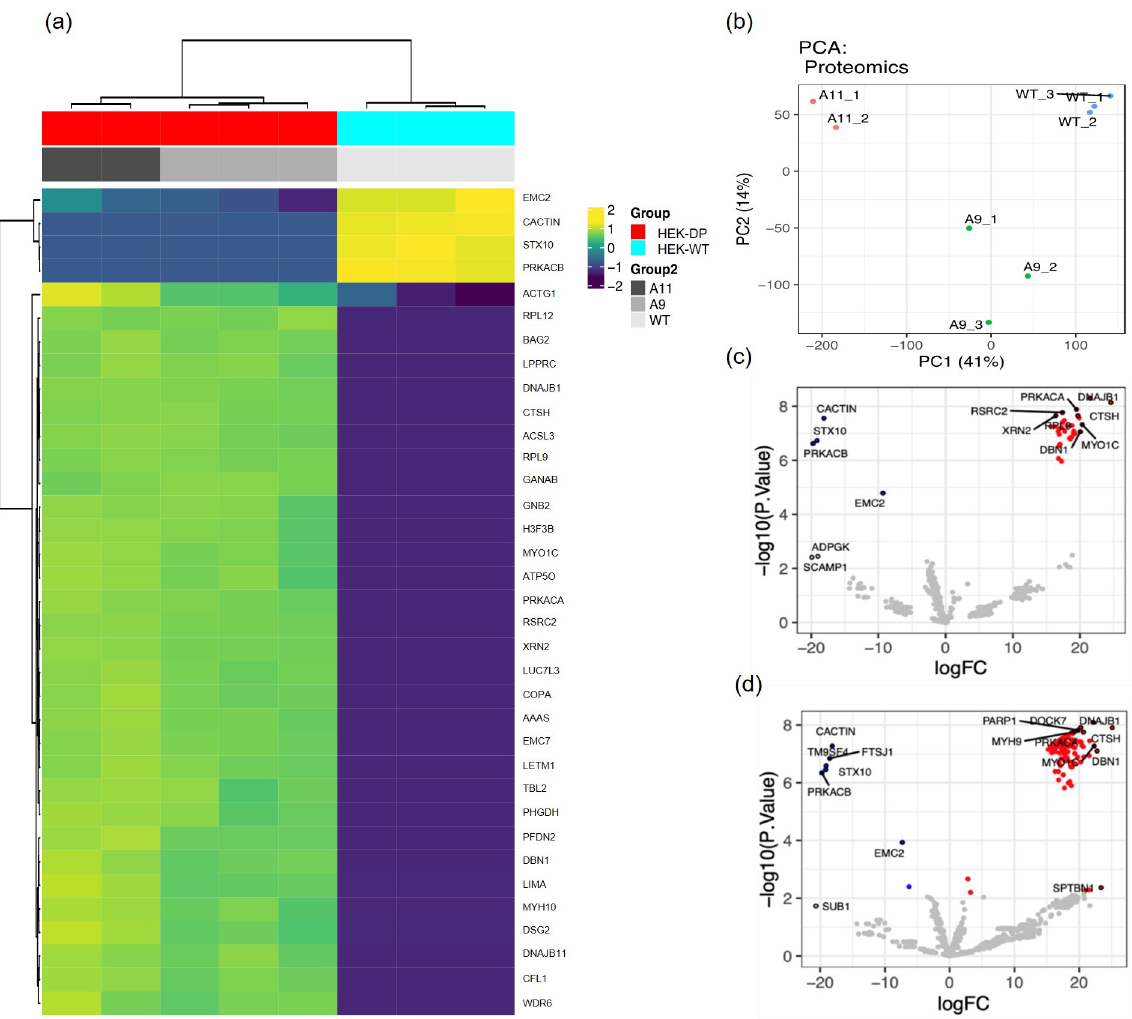
Fig 7. Proteomic analysis reveals potential DP interacting proteins. Immunoprecipitation of A11 and A9 protein homogenates with PKA-C α antibody identifies a set of proteins which are not present in HEK-WT immunoprecipitates and thus attributed to the presence of DP in these clones. Heat map (a) and principal component analysis (b) demonstrate similarities between A9 and A11 as well as tight grouping of the replicate analyses, respectively. Volcano plots highlight potential DP interacting proteins (red) in A9 vs HEK-WT (c) and A11 vs HEK-WT (d).